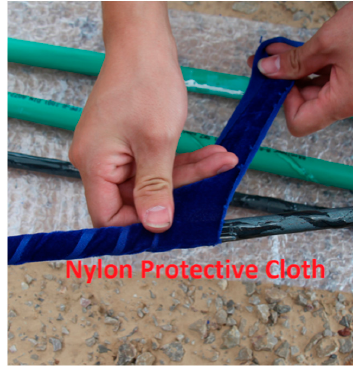
Figure 4. Protective nylon cloth layer.